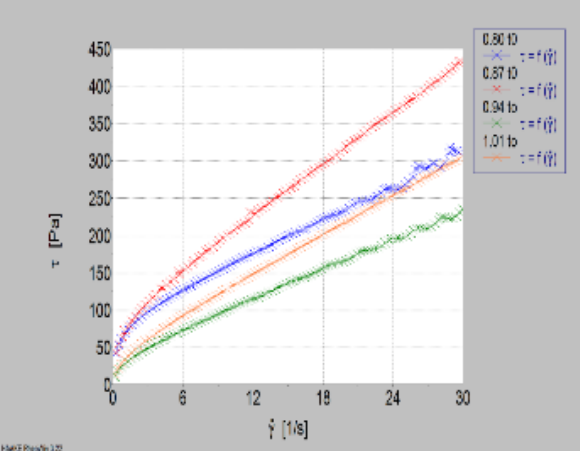
of the plot of this variation would be, in our opinion, a considerable contribution to the prediction of the P values and subsequently of the R 1 and R 2 ratios for a given solu- tion [9].